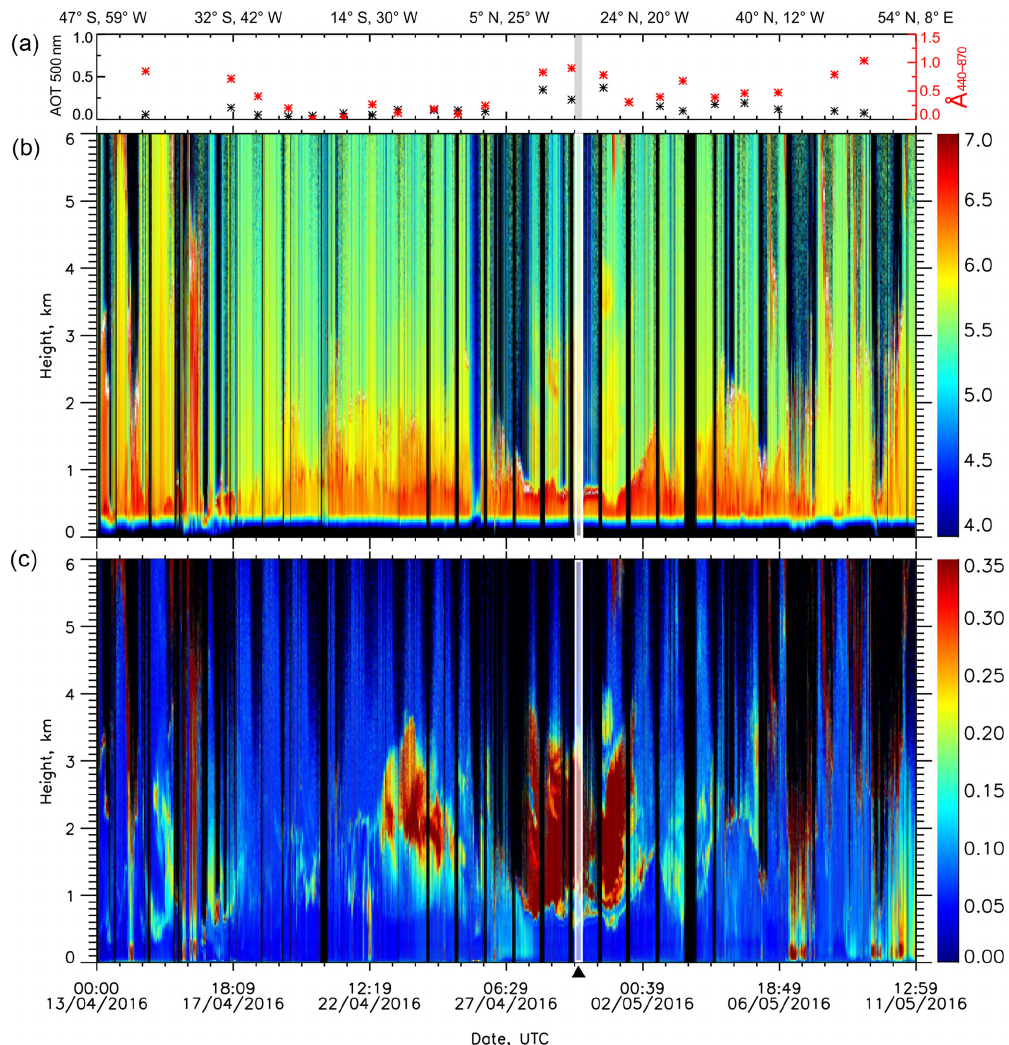
Figure 3. Same as Fig. 2 but for the spring cruise PS98 from Punta Arenas to Bremerhaven. Due to the failure of the 1064nm channel, the 532nm range-corrected signal is shown in the middle panel. The white bar indicates the time period of the case study discussed in Sect.